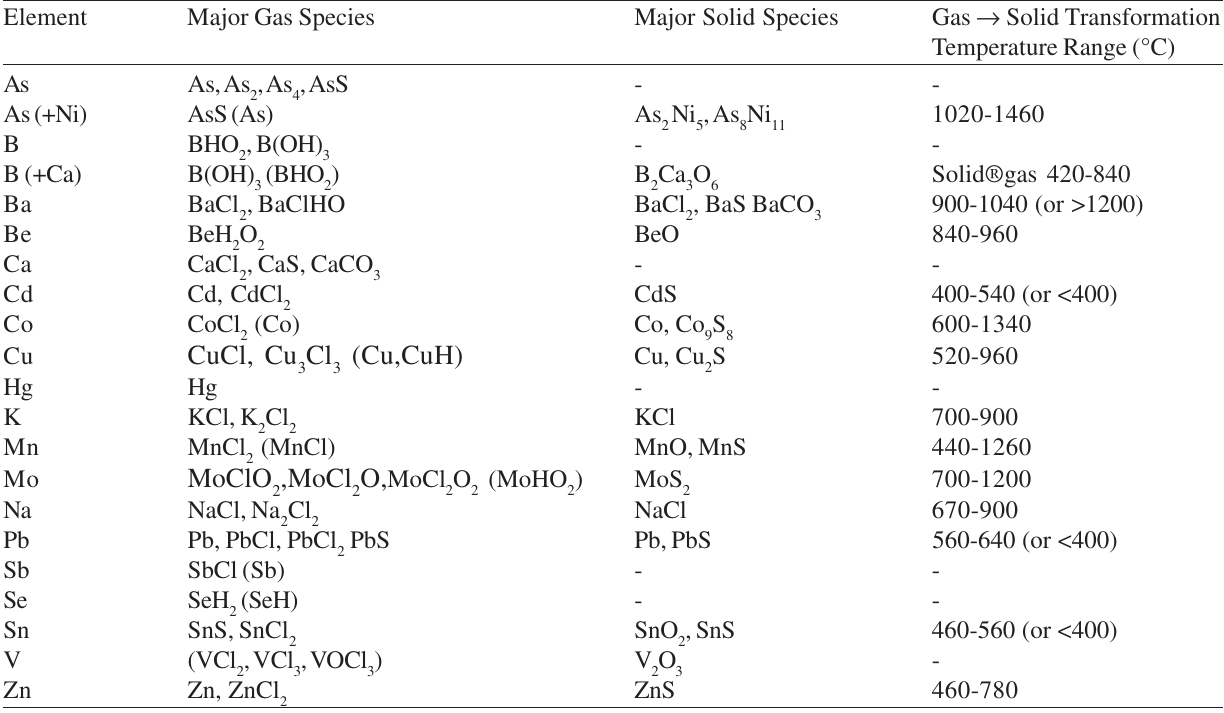
Table 3 . Summary of trace and alkali metal behaviour in gasifier gases.